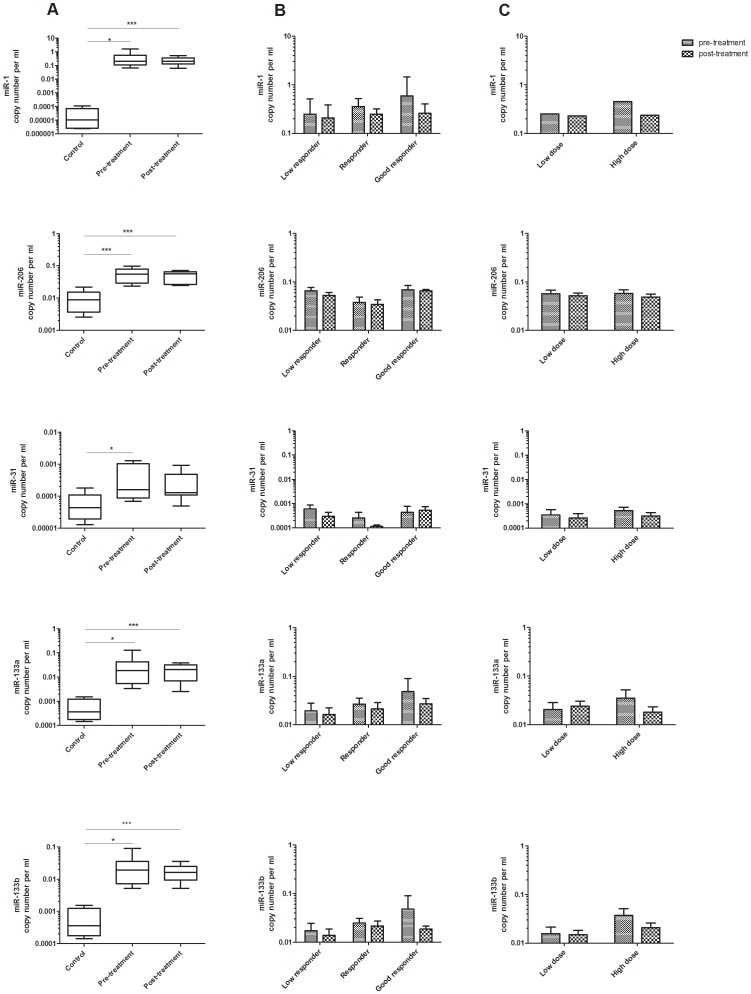
miRNAs as biomarkers for the outcome of therapeutic interventions: Systemic eteplirsen treatment trial.Absolute quantification of miR-1, miR-206, miR-31, miR-133a and miR-133b in serum of: A. DMD patients before treatment with eteplirsen (pre-treatment), after treatment (post-treatment) and controls; B. low responders, responders and good responders; C. patients who received low dose and patients with high dose of eteplirsen. The data are presented in a logarithmic scale as miRNA copy number per ml normalized to the spiked-in C. elegance miRNAs (cel-miR-54, cel-miR-39, cel-miR-238). P-values derived from two-tailed t-test are presented with *, *** and correspond to p <0.05 and p<0.001 respectively.